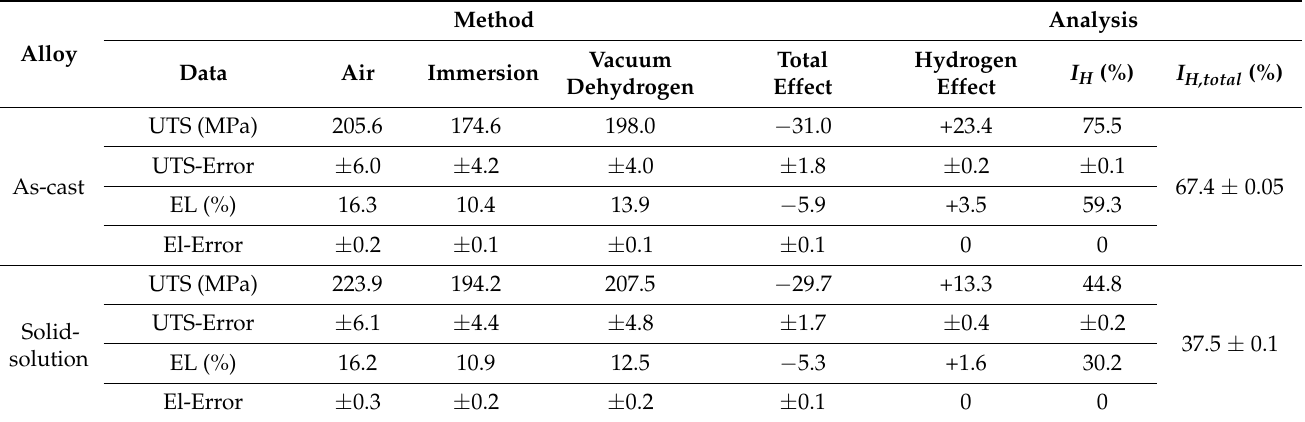
Figure 6. SSRT curves in air, for pre-immersion in 3.5% NaCl solution for 24 h, for vacuum dehy- drogenation after pre-immersion in 3.5% NaCl solution for 24 h and in 3.5% NaCl solution of the ( a ) as-cast and ( b ) solid-solution-treated AM50 magnesium alloy samples. Table 2. UTS and El data of the SSRT curves under di ff erent conditions in Figure 6.